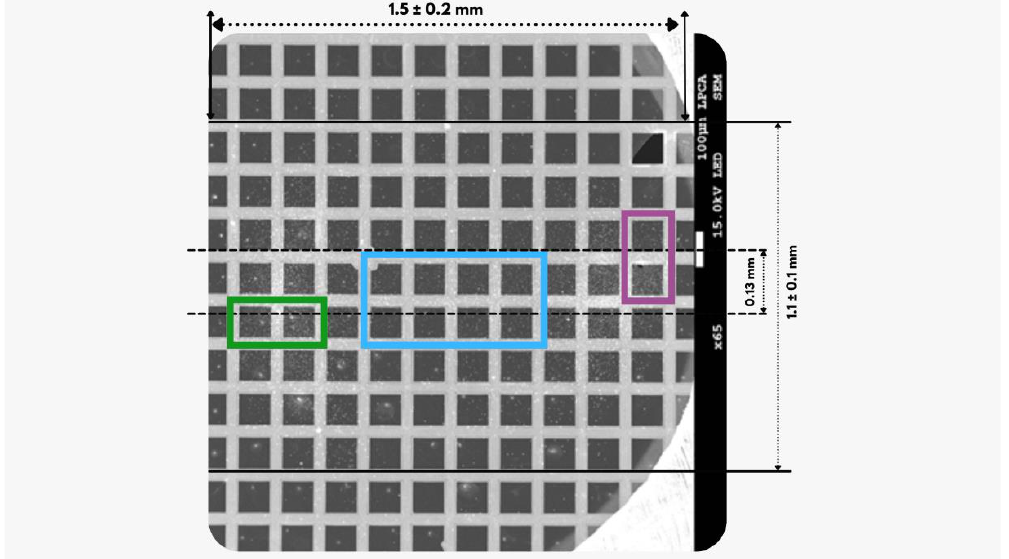
Figure 8. Image of the TEM grid (fine stage) used to evaluate the homogeneity of the repartition of impacted particles. The width of the impaction trace is marked by 2 horizontal lines and the nozzle width by 2 dotted lines. Green, blue and purple rectangles represent the analyzed areas.